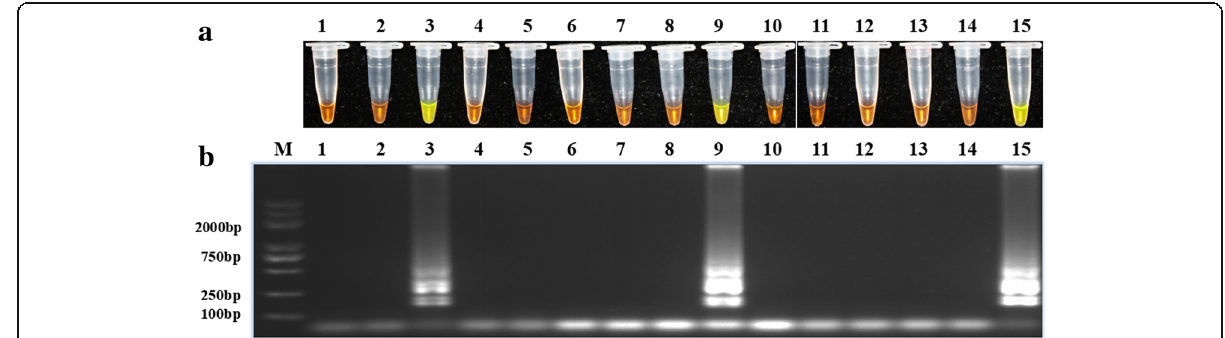
Fig. 2 LAMP primer set designed to amplify the E198K, E198A and E198V mutations in Botrytis cinerea, respectively . a LAMP products detected with 1000 × SYBR Green I. b Detection of LAMP products by agarose gel electrophoresis. Lane M: DNA 2 K plus Marker; tubes and lanes 1 – 5: primer set Tub-E198K; tubes and lanes 6 – 10: primer set Tub-E198A; tubes and lanes 11 – 15: primer set Tub-E198V; tubes and lanes 1, 6, 11: ddH 2 O; tubes and lanes 2, 7, 12: HBStr-104; tubes and lanes 3, 8, 13: HBStr-155; tubes and lanes 4, 9, 14: HBStr-114; tubes and lanes 5, 10, 15: HBStr-496